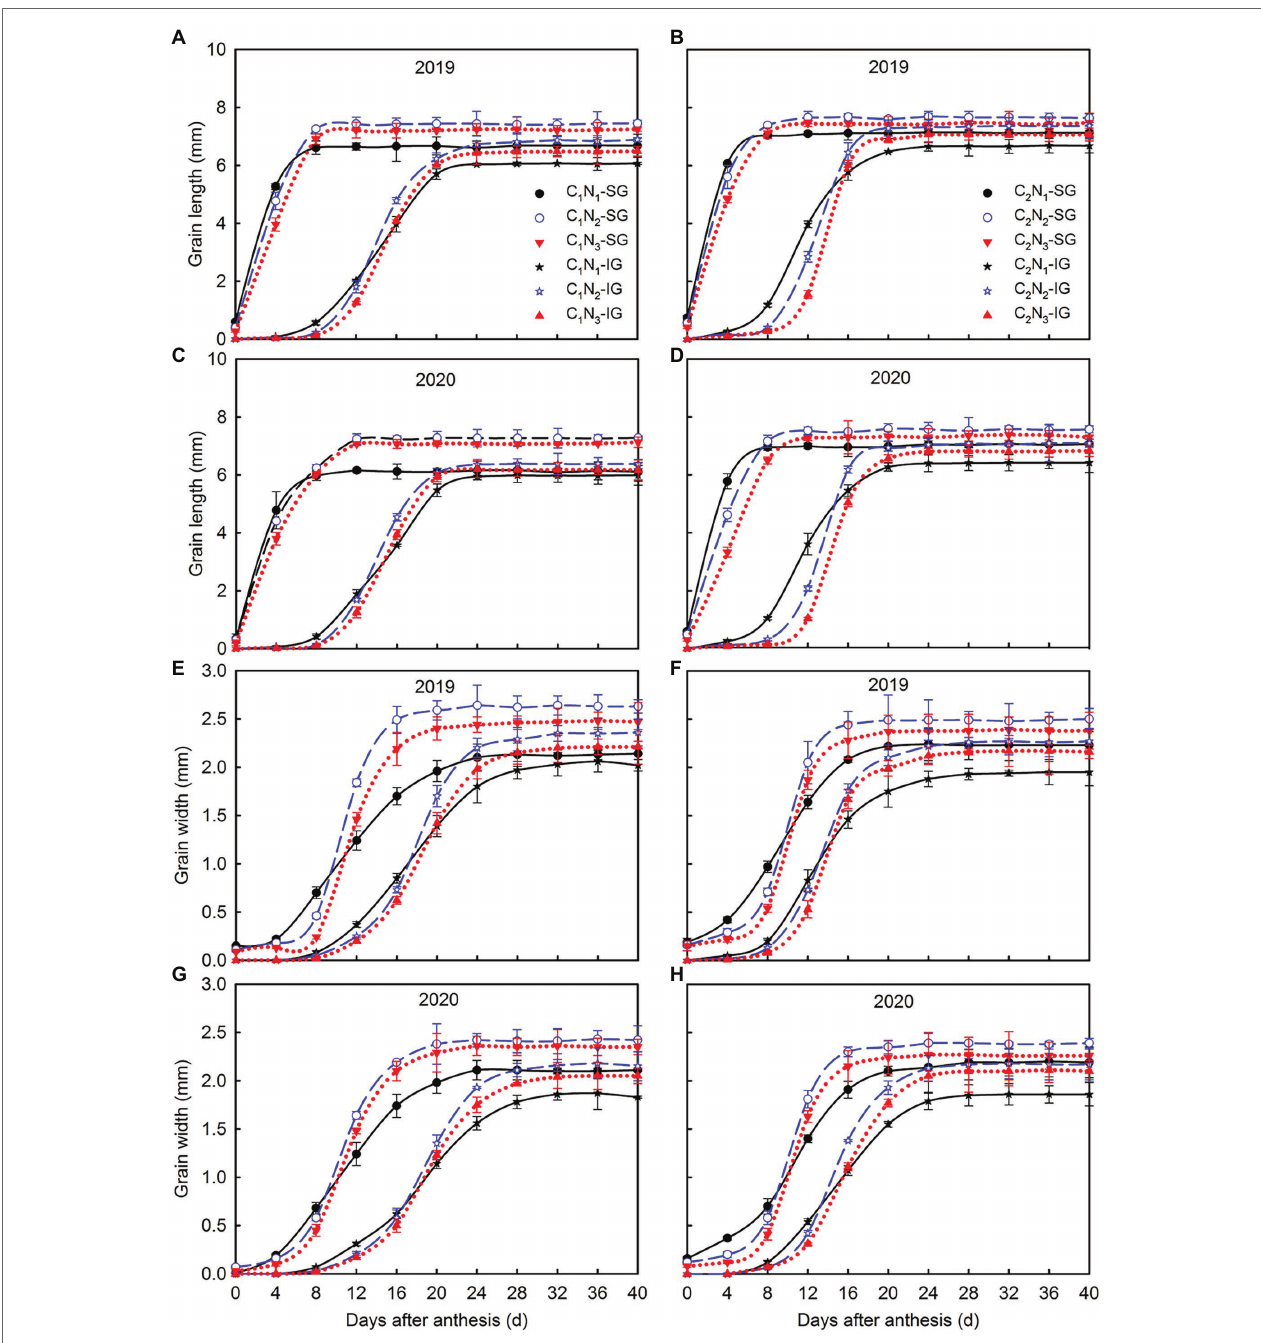
FIGURE 5 | Changes of length (A–D) and width (E–H) of superior and inferior grains under different N application rates. Data are mean ± SE ( n = 3). SG: superior grain; IG: inferior grain;